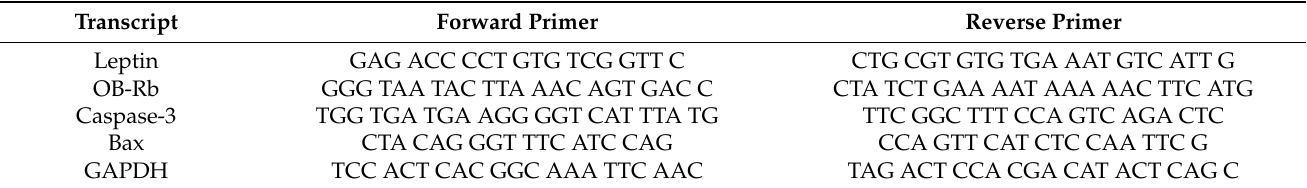
Table 1. PCR primers used in this